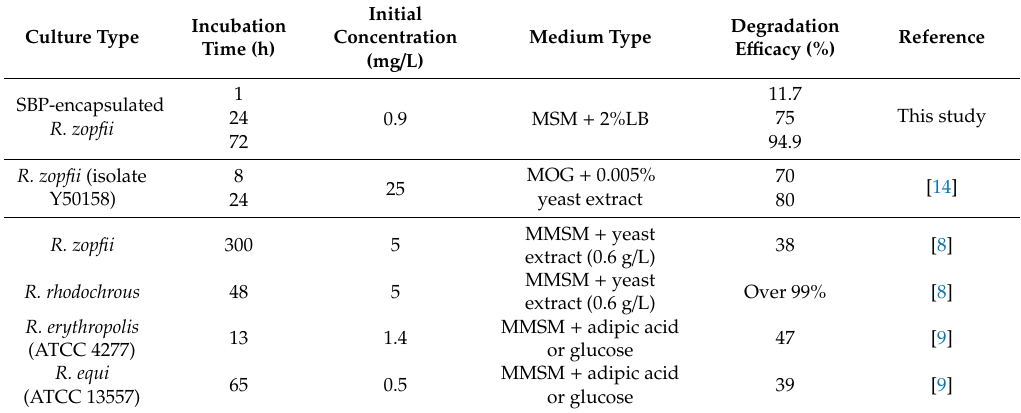
Table 2. Selected literature results for EE2 biodegradation e ffi cacy by Rhodococcus species metabolic activity in the presence of other carbon sources.